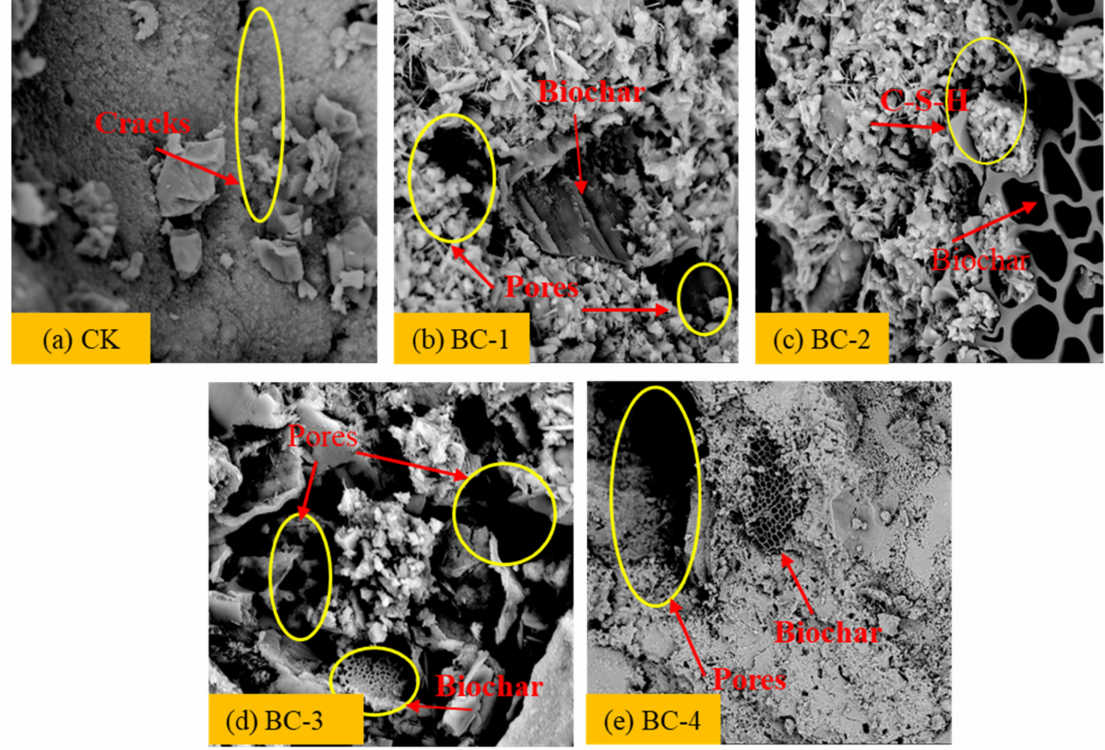
Figure 8. SEM images of concrete with different fineness levels of biochar with 3%